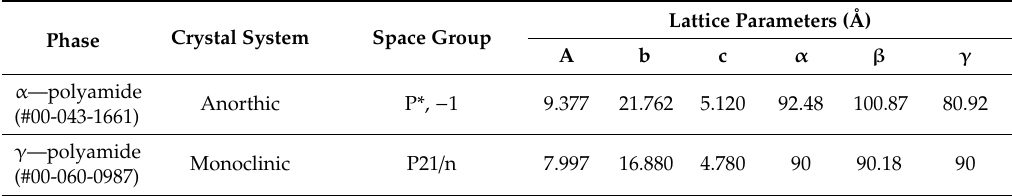
Table 3. Crystallographic data for fitted